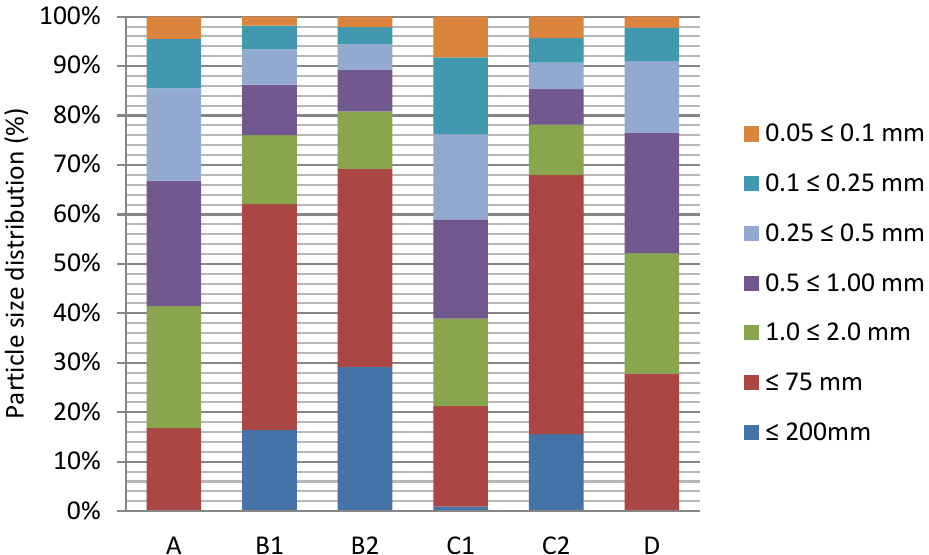
Figure 2. Particle size distribution (%) depending on the sampling location: A (inter-railway, depth 20 cm), B1 (5 m from the main track, depth 0–5 cm), B2 (5 m from the main track, depth 20 cm), C1 (embankment, 10 m from the main track, depth 0–5 cm), C2 (embankment, 10 m from the main track, depth 20 cm), D (side track, depth 20 cm).